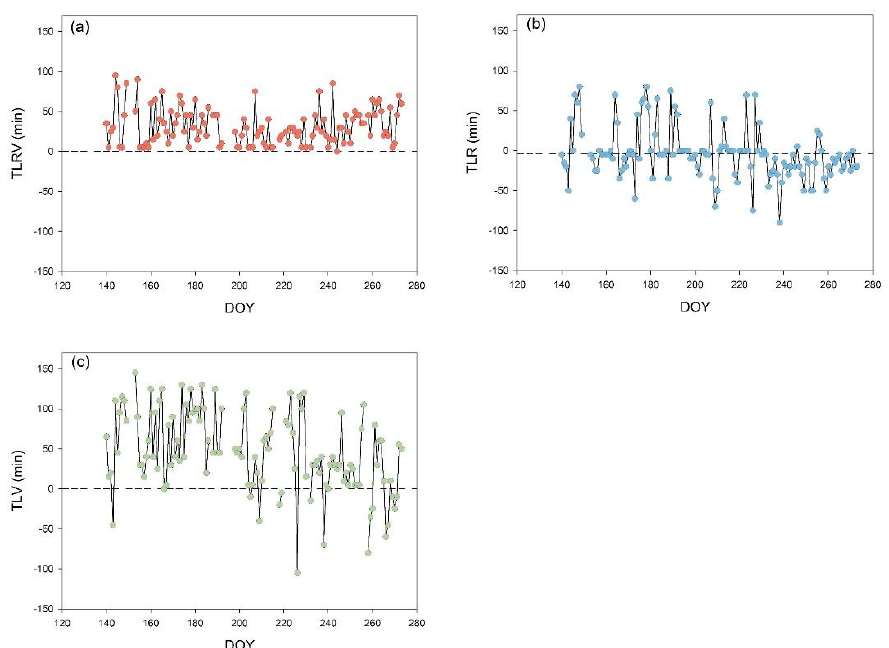
Figure 5. Diurnal time lag fluctuations in the growing season: ( a ) Time lag between vapor pressure deficit and solar radiation (TLRV); ( b ) time lag between sap flux density and solar radiation (TLR); ( c ) time lag between sap flux density and vapor pressure deficit (TLV). Positive time lag values represent J s (sap flux density) peaks preceding peaks in meteorological drivers; negative time lag values represent J s peaks lagging behind peaks in meteorological drivers. (DOY = day of the year).